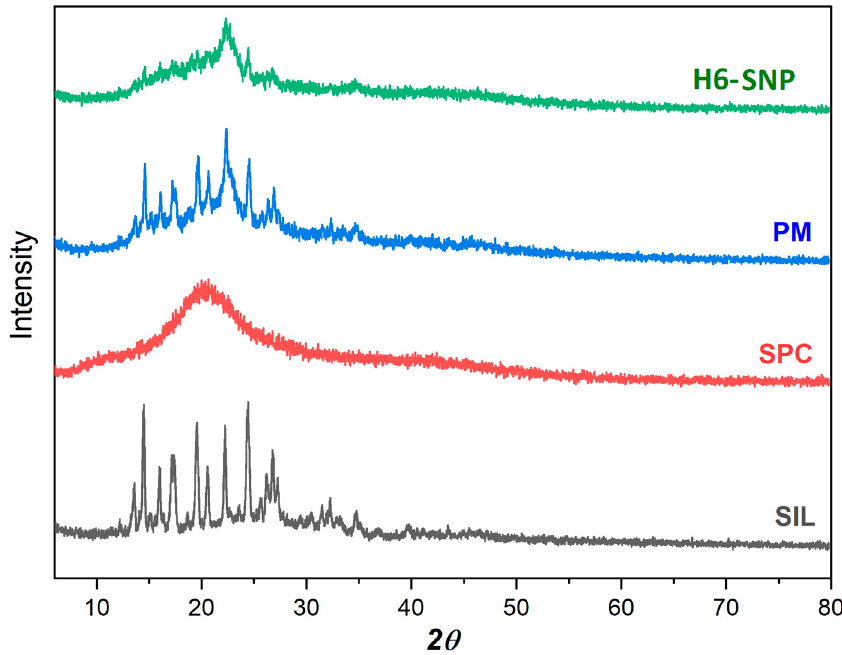
Figure 4. A Multiview Powder X-Ray Diffraction p-XRD diffractograms of SIL, SPC, PM and H6- SNP.